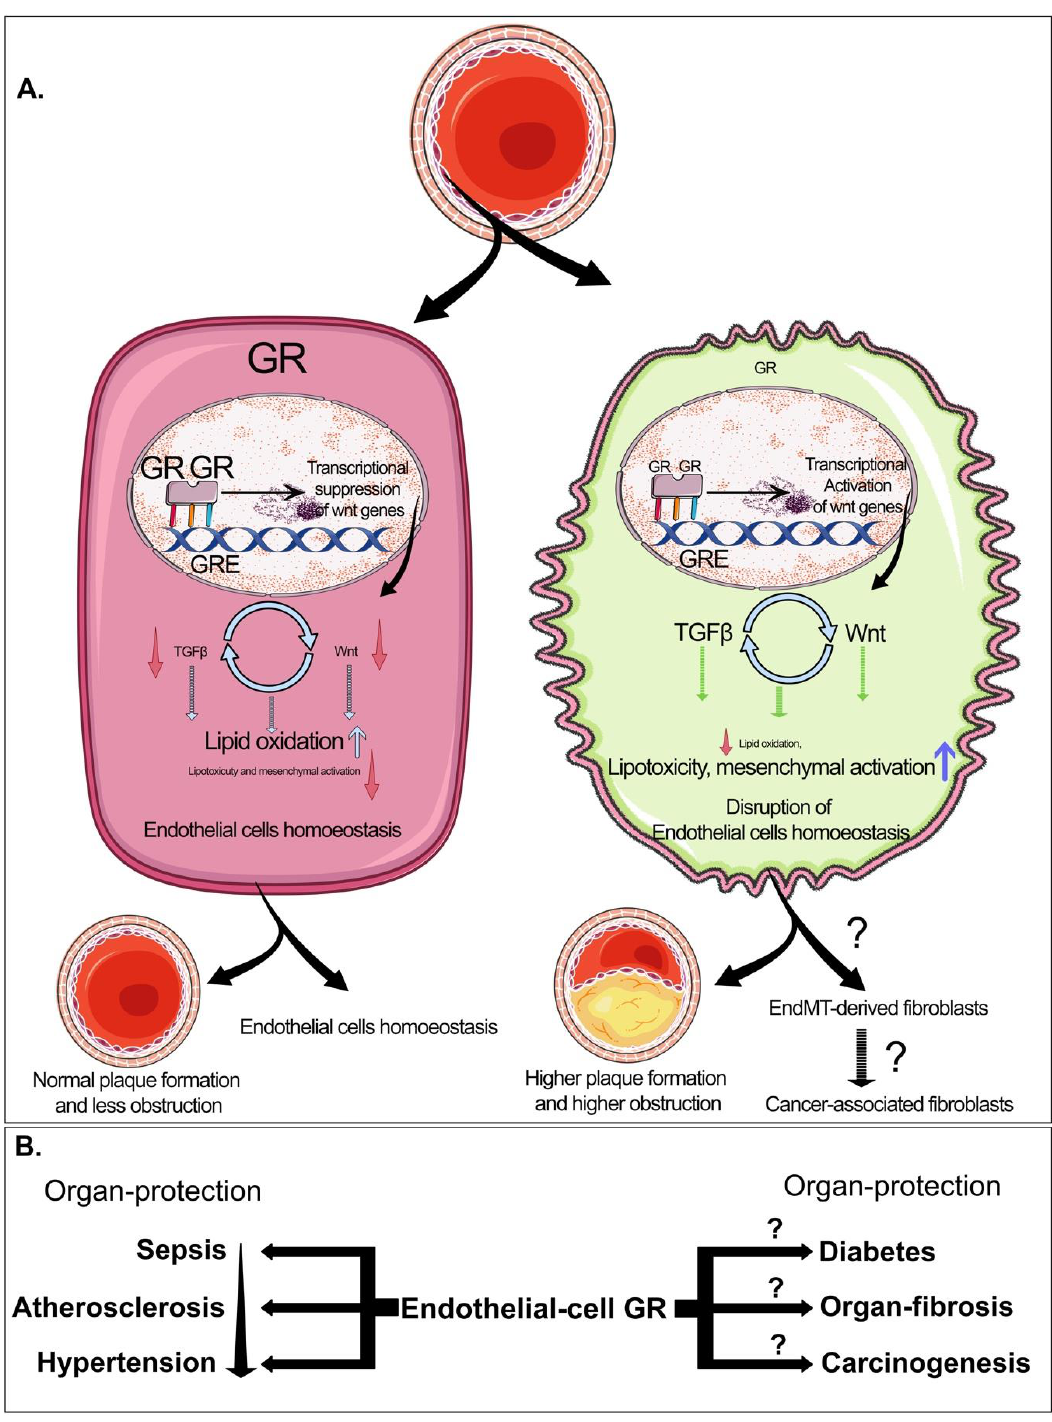
Figure 4. Functional significance of glucocorticoid receptor in endothelial cells. A. In normal endothelial cells, in the presence of GCs, GR binds to GREs and activates the transcription and trans-repression of genes responsible for canonical Wnt signaling. Suppressed Wnt/TGF- β signaling leads to lipid homeostasis and low levels of EndMT, therefore contributing to endothelial cell homeostasis. In diabetic endothelial cells, GR level is suppressed, leading to transcriptional activation of genes in the canonical Wnt signaling pathway. Higher levels of Wnt-dependent TGF- β signaling lead to disruption in lipid homeostasis and higher levels of EndMT, thereby disrupting endothelial cell homeostasis. B. Flowchart showing the role of endothelial cell GR in organ protection.